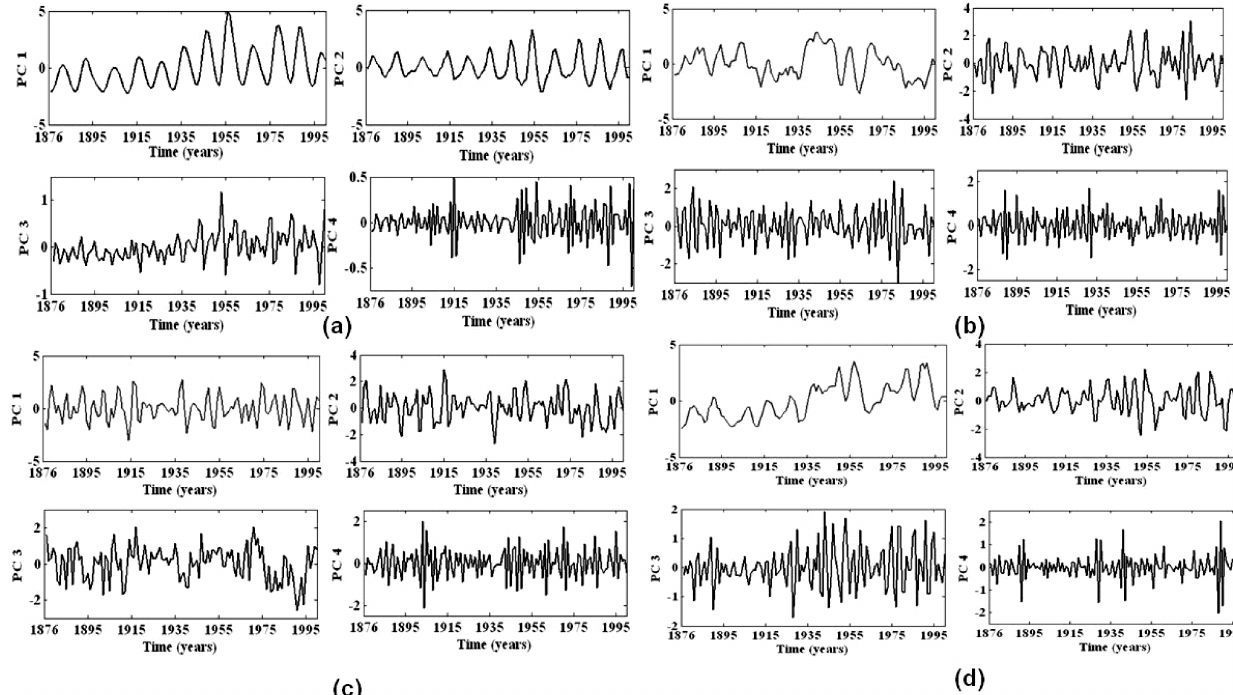
Figure 2. First four principal components (PCs 1–4) for time series: (a) sunspot numbers, (b) the mean pre-monsoon temperature anomalies of the Western Himalayas, (c) SOI index and (d) geomagnetic indices (aa indices) for the period